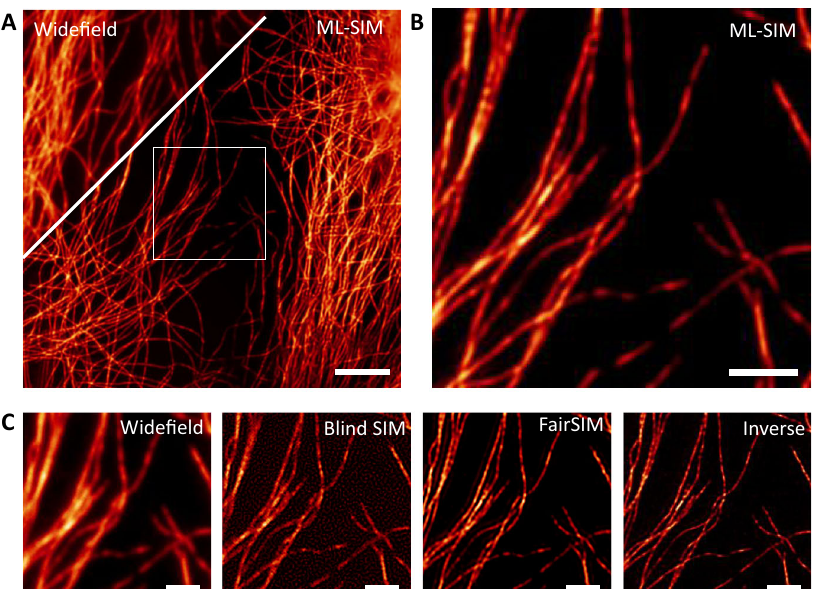
Fig. 3 | Reconstructions of MAI-SIM data from fi xed cells. Fixed COS7 cells containing beta-tubulinlabeled withsecondary antibodiesconjugated to Alexa568 dye. A Comparison of diffraction limited wide fi eld images and ML-SIM recon- struction overthe full fi eldof view. Scalebaris 5 µ m. B Machine Learning (ML-SIM) reconstruction formagni fi ed regionindicated in A .Scale baris1 µ m. C From leftto right: wide fi eld, Blind SIM, FairSIM, and inverse matrix reconstructions over the